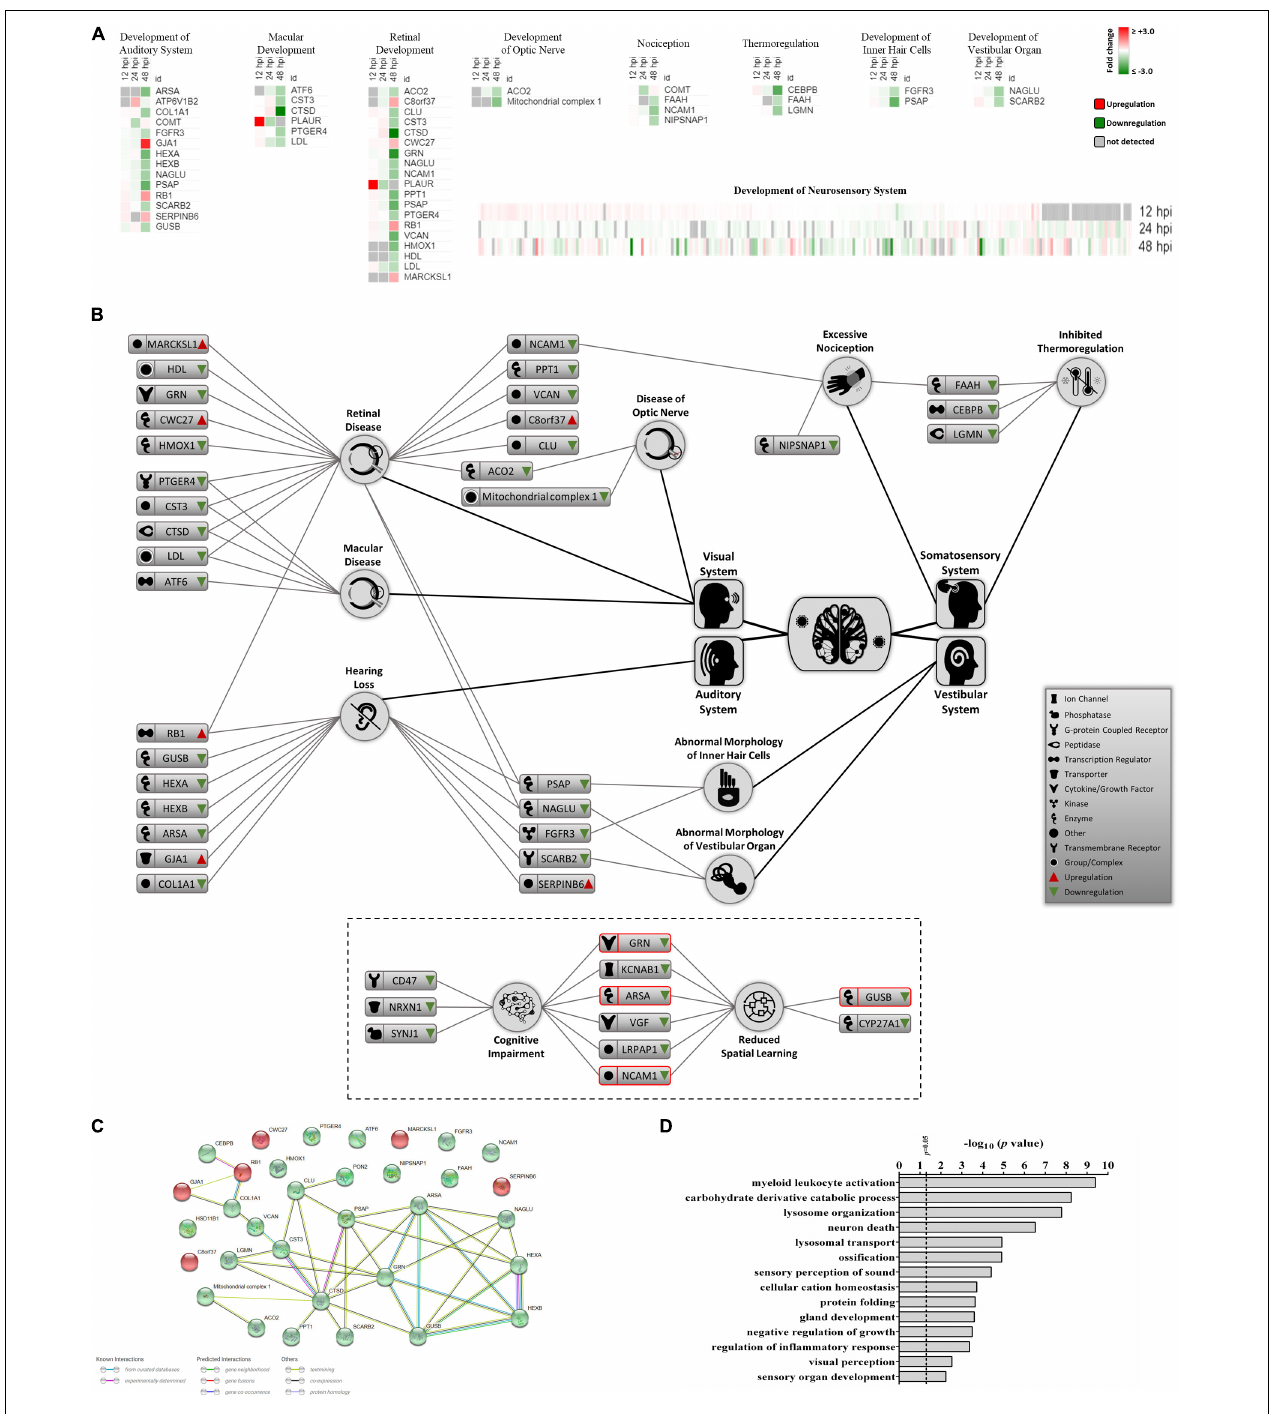
FIGURE 4 | Proteomic prediction of ZIKV-induced changes in the neurosensory system. (A) Heatmaps of significantly dysregulated proteins involved in the development of neurosensory system. Most significant changes belonged to the 48 hpi dataset. Specific heatmaps that cover different subsets of neurosensory system are shown in upper panels. Lower panel represents the global overview heatmap for all proteins regulating the development of neurosensory system across three time-points from ZIKV-infected Vero cells. (B) Graphical representation of predicted ZIKV-triggered dysregulations in different parts of the neurosensory system by 2 dpi. Lower bordered panel indicates that a few proteins (ones with red margins) with influences on sensory nervous system together with some other differentially expressed proteins at 48 hpi could influence cognitive and learning functions based on IPA predictions. (C) Protein-protein interaction assessment of significantly regulated proteins causing neurosensory impairments based on their levels at 48 hpi. (D) Gene ontology analysis within the single class of biological process showing top affected pathways based on significantly dysregulated proteins with functions in neurosensory system at 48 hpi.